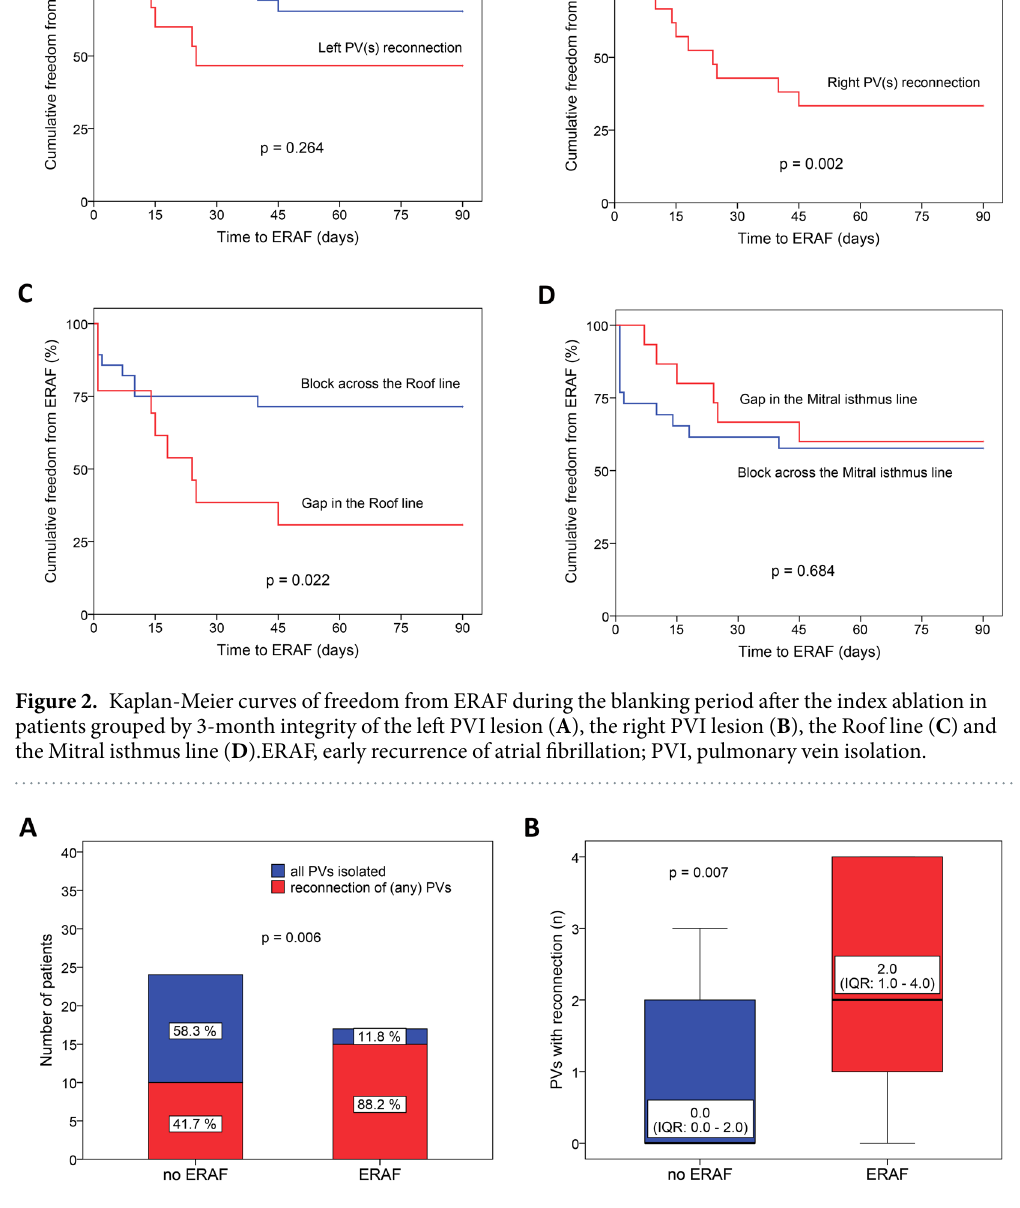
Figure 3. The prevalence ( A ) and the extensiveness ( B ) of PV reconnection at 3 months among patients with and those without ERAF. PV, pulmonary vein; ERAF, early recurrence of atrial